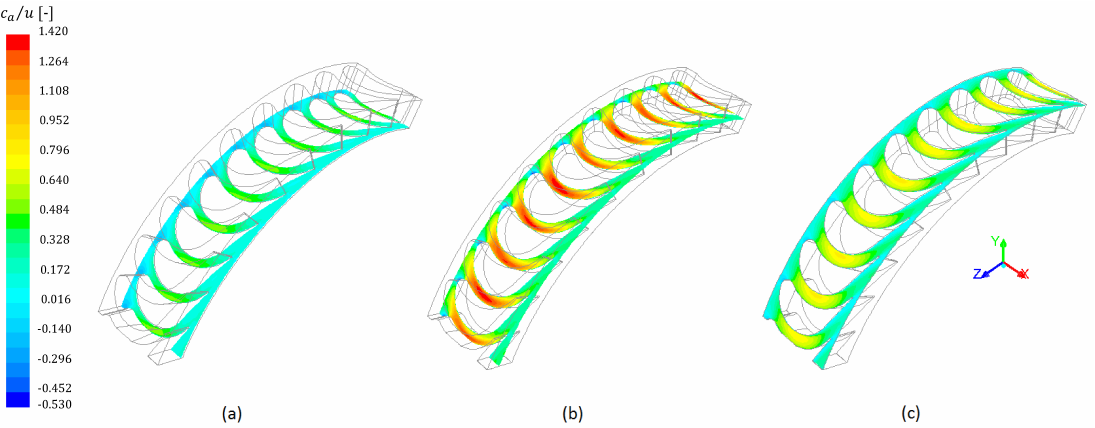
Figure 15. Contours of normalized axial velocity at ( a ) hub, ( b ) mid, and ( c ) tip of rotor blade passages.